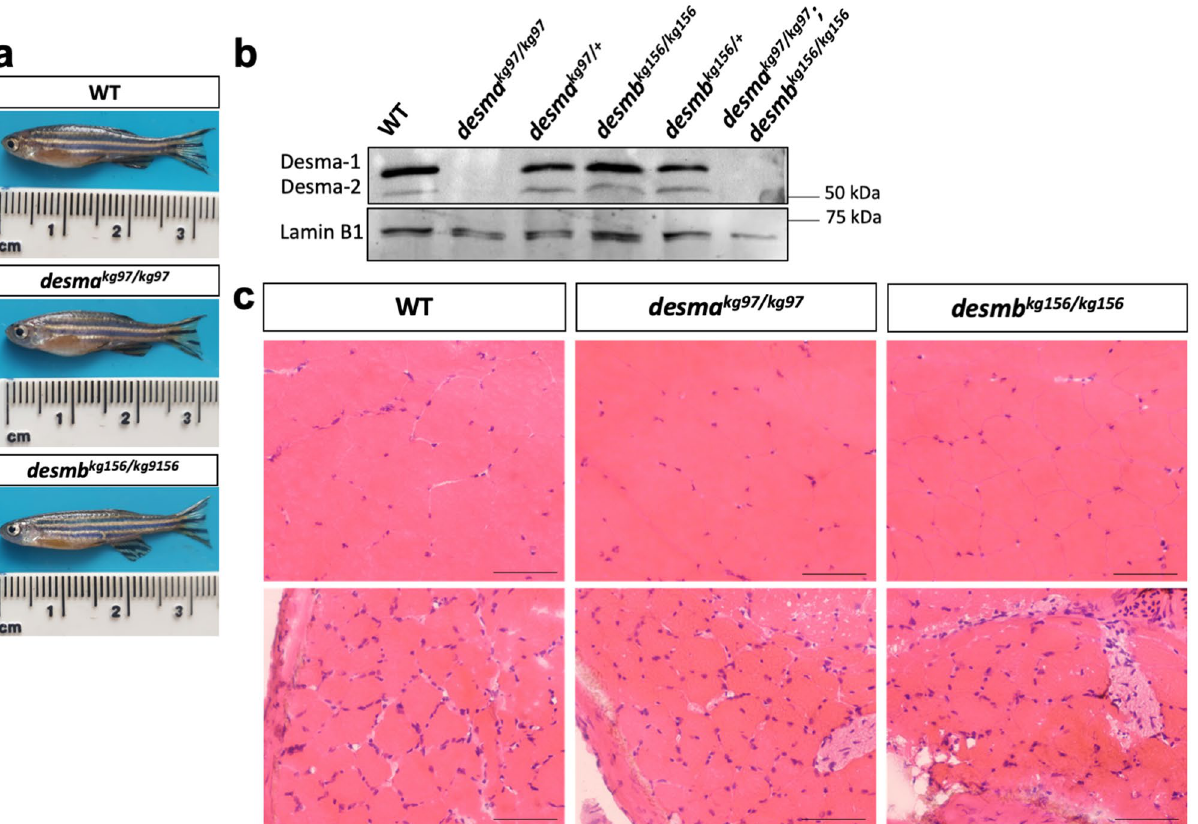
Figure 5. Desmin protein expression and histological examination of adult skeletal muscle. ( a ) Photographs of 1 year-old anesthetized fish. ( b ) Immunoblotting of skeletal muscle protein extracts of WT, desma kg97/kg97 , desma kg97/ + , desmb kg156/kg156 , desmb kg156/ + and desma kg97/kg97 ;desmb kg156/kg156 double mutant fish probed with anti- desmin antibody. Lamin B1 was labeled on the same blot as loading control. Uncropped full-length pictures of the blot is available in Supplementary Figure S5 online. ( c) Transversal cryosections of mid-trunk somites from two different areas of WT and homozygous mutant adults stained with hematoxylin eosin showing no pathological changes. Scale bar: 25